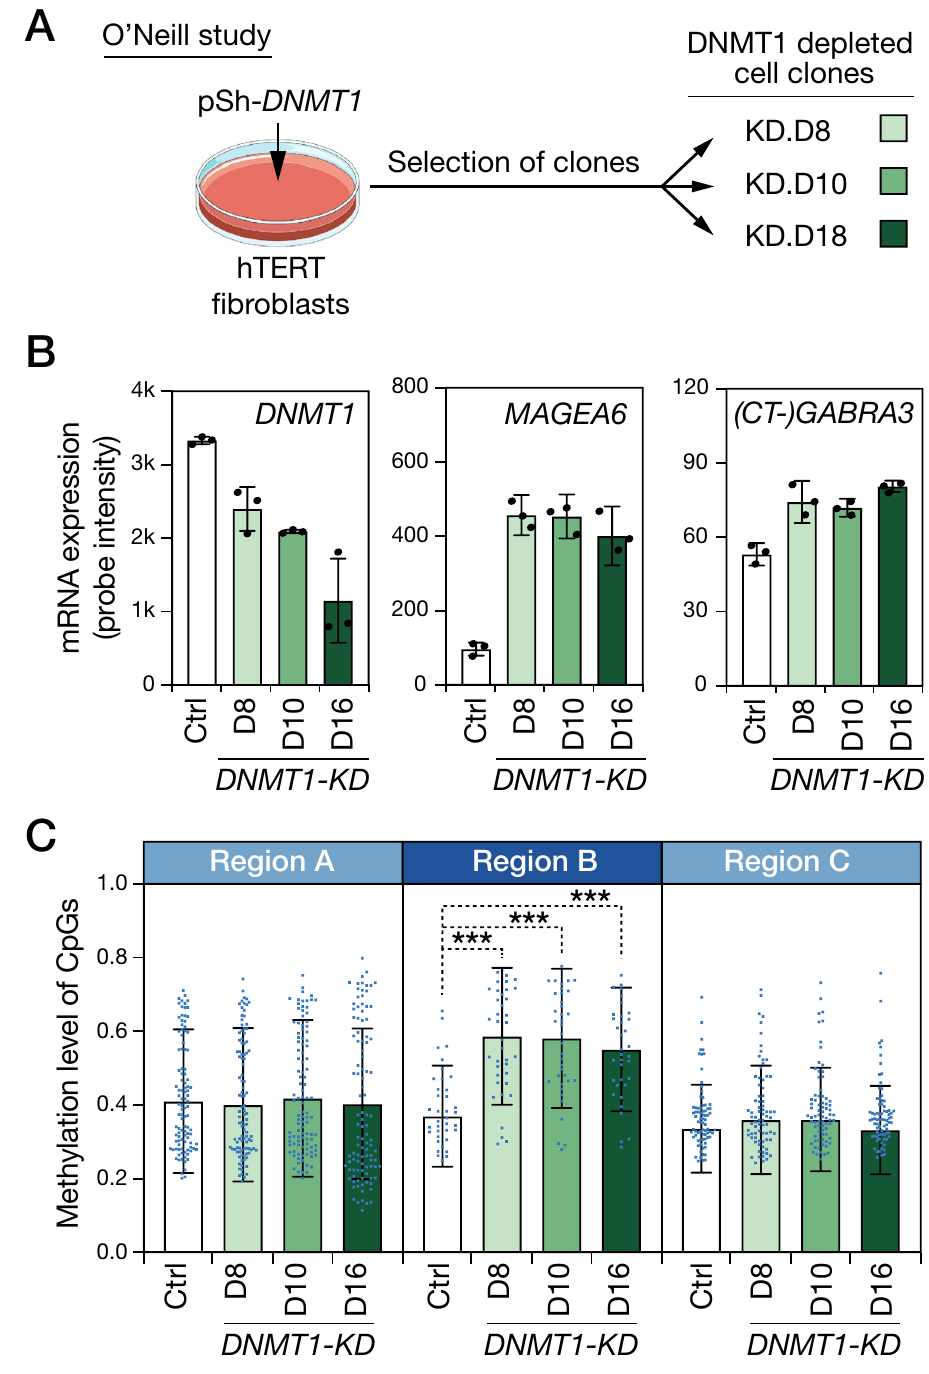
Figure 3. Experimental hypomethylation/activation of CT-GABRA3 induces de novo methylation of CpGs within its transcription unit. ( A ) Diagram depicting O’Neill’s experiment. Clones were derived from hTERT- immortalized human male fibroblasts transfected with an anti-DNMT1 shRNA producing vector (pSh- DNMT1 ). ( B ) cDNA microarray data were analyzed to determine relative mRNA levels of DMNT1 , MAGEA6 and ( CT- ) GABRA3 (the two transcript variants cannot be distinguished by microarray), in the control hTERT fibroblast cell line (Ctrl) and in the three DNMT1-depleted clones (D8, D10 and D18). ( C ) Infinium methylation data were used to determine mean methylation levels of all CpGs (mean probe intensity ratios) in the control cell line and the DNMT1-depleted clones. Analyses are provided for the CT-GABRA3 transcription unit (Region B ), and the two neighboring segments (Regions A and C, see Fig. 2B). ***One-way paired ANOVA test with Dunnett’s correction, p -value <